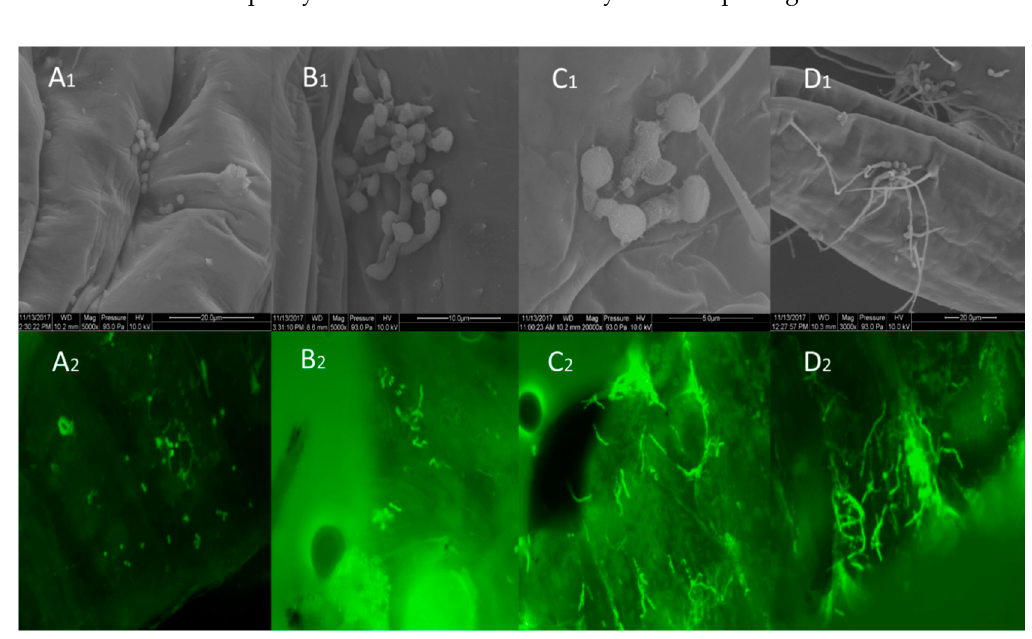
Figure 2. Beauveria bassiana GZGY-1-3 infecting pre-pupae of Frankliniella occidentalis as shown by scanning electron microscopy (SEM) (A1–D1) and fluorescence microscopy (A2–D2). A1 and A2: Conidia attached to the cuticle of F. occidentalis 2 h after immersion. B1 and B2: Germination of conidia on the insect cuticle. C1 and C2: Development of appressoria by B. bassiana germ tubes after 36 h. D1 and D2: Growth of B. bassiana hyphae over the surface of the pre-pupae after 60